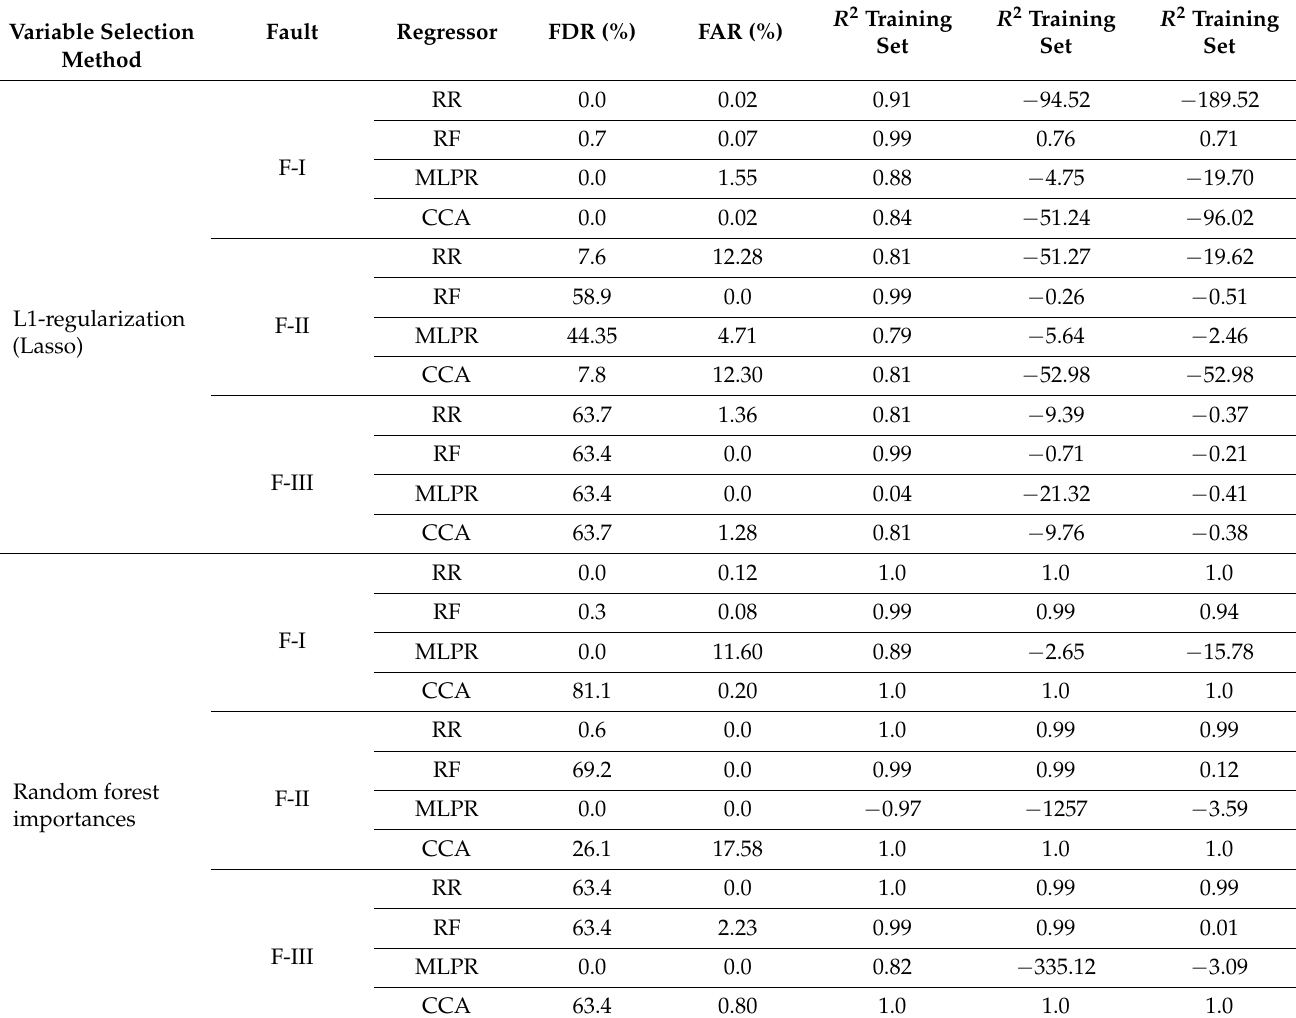
Table 9. Performance when embedded-based variable selection procedures were used to analyze the industrial data. Variable